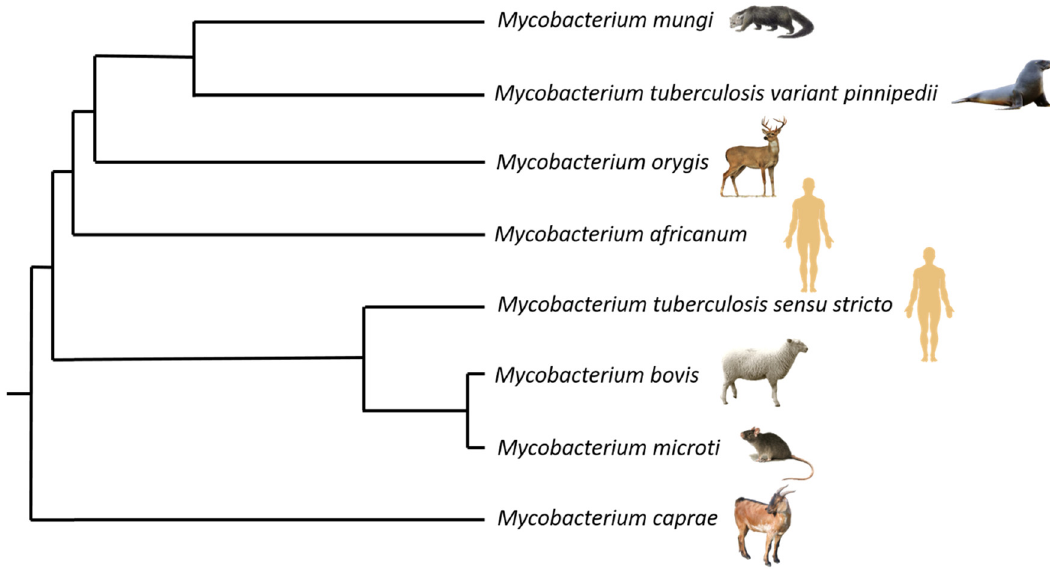
Figure 1: Species of Mycobacterium and their various adapted hosts. Some might infect multiple hosts but M. africanum and M. tuberculosis sensu stricto are known to infect only